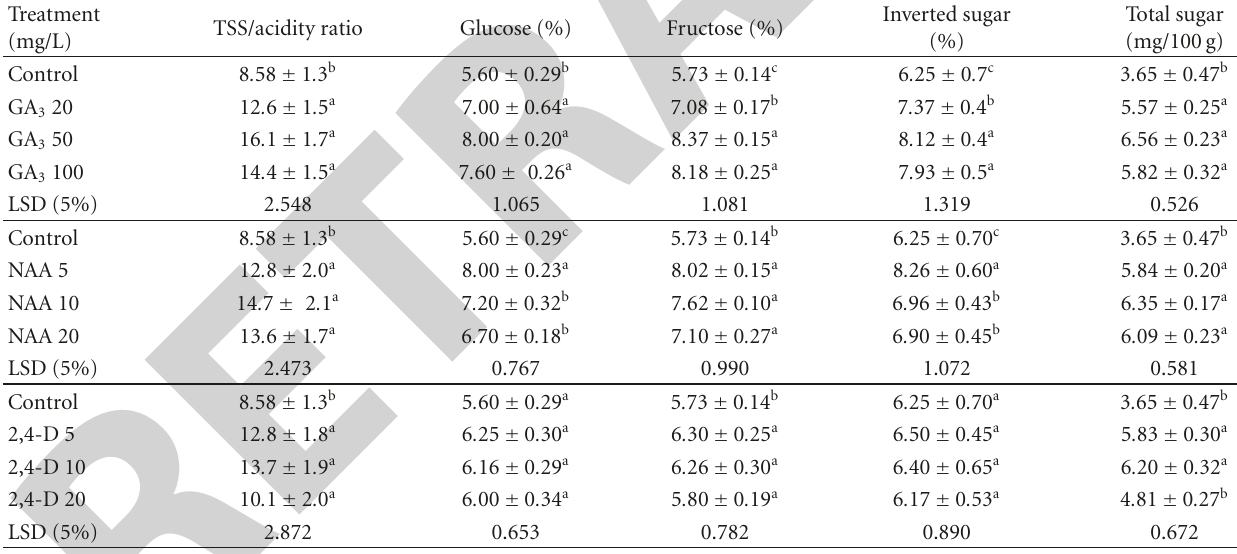
Table 2: E ff ects of growth regulators on TSS/acidity ratio, soluble carbohydrates, and total sugar content of wax apple